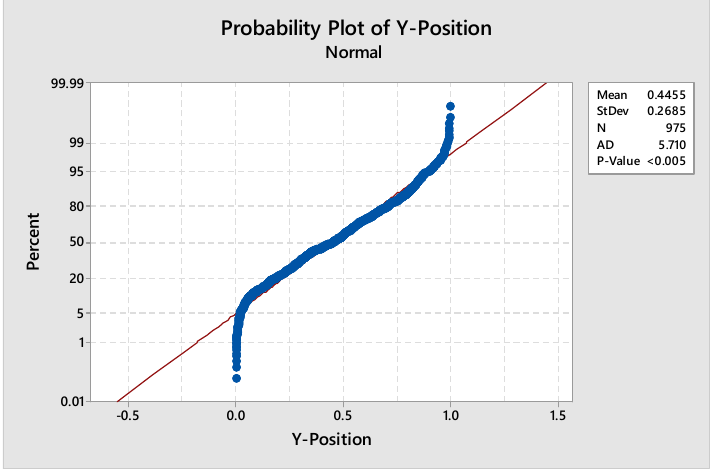
Figure 13. Probability plot for Y Position.